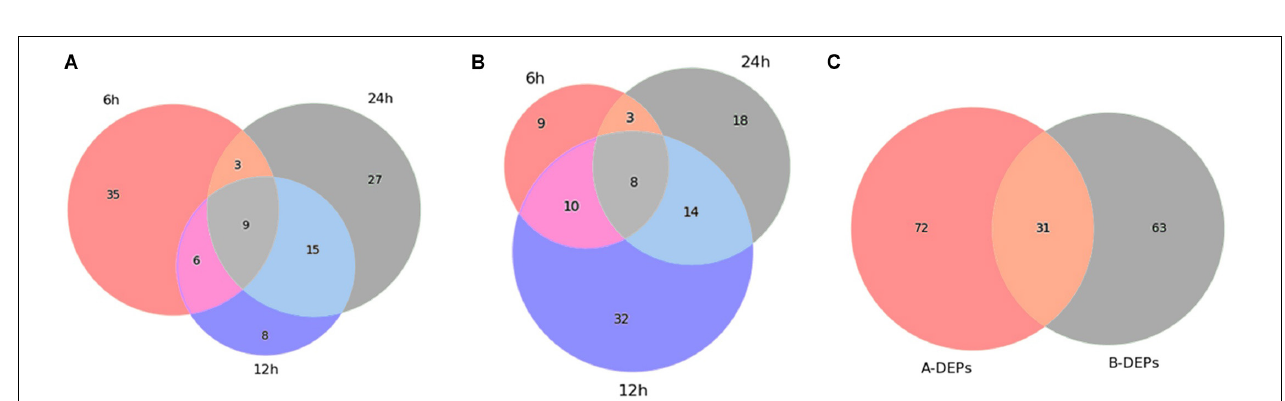
FIGURE 3 | Numbers of significantly DEPs, including the up- and down-regulated proteins in PtK2 cells with the citreamicin ε A (A) and B (B) treatment for 6, 12, and 24 h, respectively.